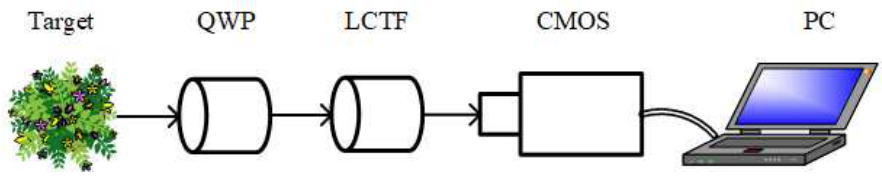
Figure 1. The schematic diagram of FPCHI